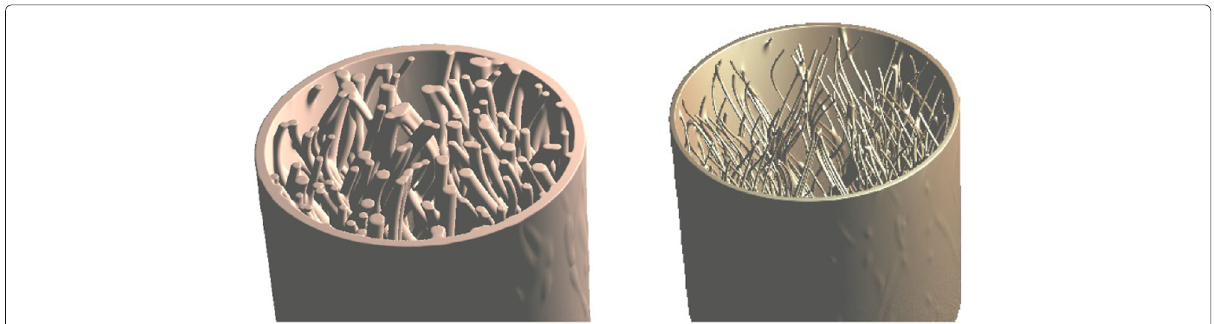
Fig. 11 The volumetric nature of biological tissue structures can be represented directly as the blending of an implicitly represented solid shape and its interior tissue